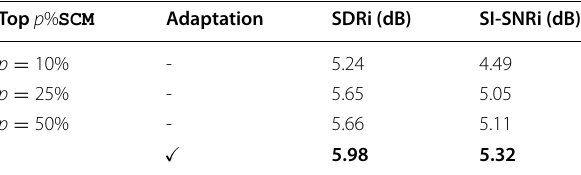
“-” means training model from scratch with only pseudo labeled data. “ (cid:31) ” means adapting model with the combined pseudo labeled data and the source